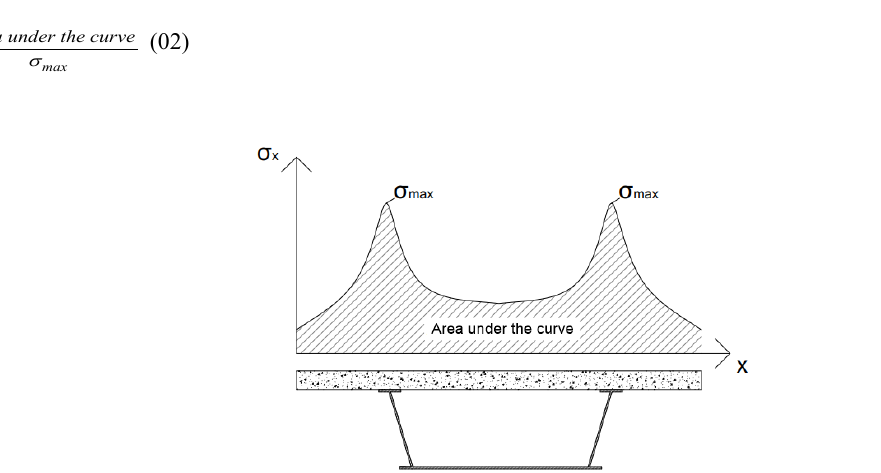
Figure 9. Variables for calculating the effective numeric width.